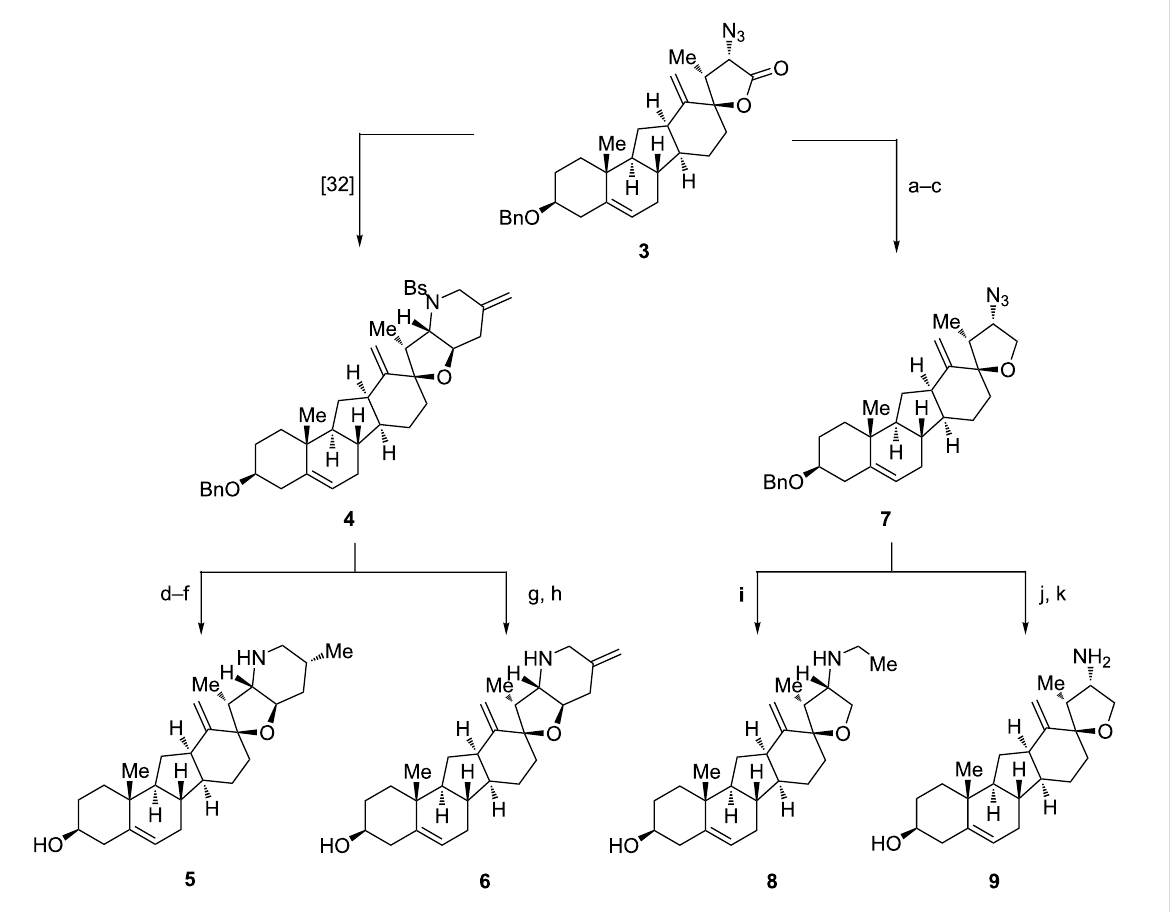
Scheme 1: Synthesis of 25-epi- exo -cyclopamine 5 , bis- exo -cyclopamine 6 , and derivatives 8 and 9 . Reaction conditions: (a) DIBAl-H, THF, − 78 °C to − 65 °C, 4 h, 95%; (b) Ac 2 O, pyridine, DMAP (cat.), 25 °C, 20 h, quant; (c) BF 3 ·Et 2 O, Et 3 SiH, CH 2 Cl 2 , − 78 °C to − 20 °C, 7 h, 79%; (d) Rh(PPh 3 ) 3